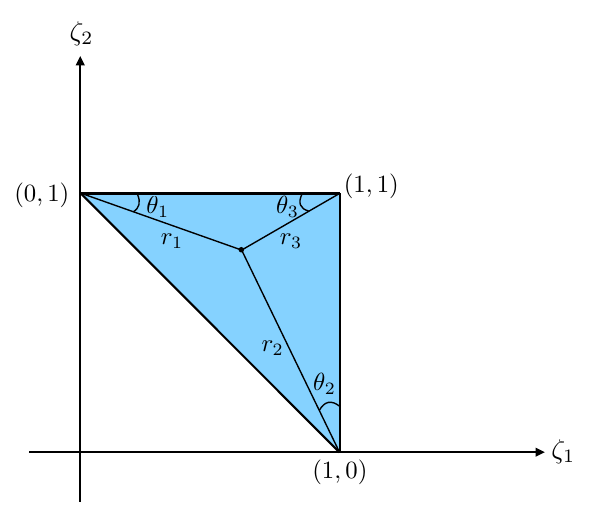
Figure 3 . Definition of ( r i , θ i ) . Due to the step function in (5.14), F 0 ( ζ 1 , ζ 2 ) is nonzero only in the blue region. The three points (1 , 0) , (0 , 1) , (1 , 1) are where F 0 ( ζ 1 , ζ 2 ) becomes